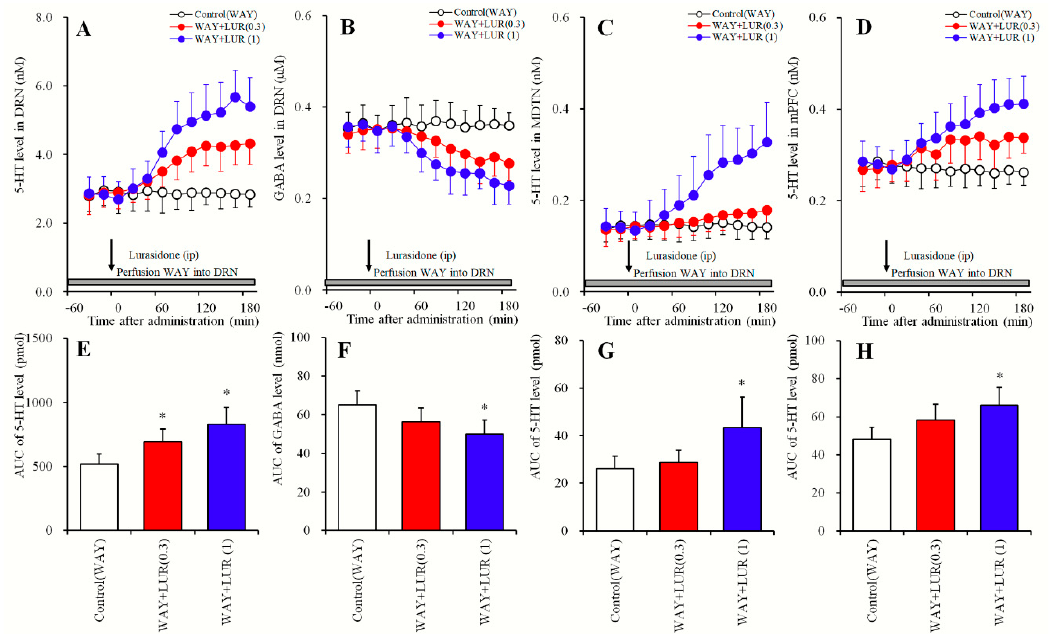
Figure 2. Dose-dependent e ff ects of systemic administration of lurasidone on extracellular levels of 5-HT in the DRN, MDTN, mPFC and GABA in the DRN during 5-HT1AR inhibition in the DRN (Study_2). ( A , C , D ) indicate dose-dependent e ff ects of systemic administration of lurasidone (LUR: 0, 0.3 and 1 mg / kg) during perfusion with 10 µ M N-[2-[4-(2-Methoxyphenyl)-1- piperazinyl]ethyl]-N-2-pyridinylcyclohexanecarboxamide (WAY100635: WAY) into the DRN on extracellular levels of 5-HT in the DRN, MDTN and mPFC, respectively. ( B ) indicates dose-dependent e ff ects of systemic administration of lurasidone (0, 0.3 and 1 mg / kg) during perfusion with 10 µ M WAY100635 into the DRN on extracellular GABA level in the DRN. Y -axis: Mean ± SD (n = 6) of extracellular levels of 5-HT (nM) and GABA ( µ M); X -axis: Time after administration of lurasidone (min). Arrows indicate intraperitoneal administration of lurasidone, and gray bars indicate the perfusion with 10 µ M WAY100635. Microdialysis was conducted to measure the releases of 5-HT and GABA. ( E – H ) indicate the AUC value of extracellular levels of 5-HT (pmol) and GABA (nmol) after systemic administration of lurasidone from 20 to 180 min of ( A – D ), respectively. Opened, red and blue columns represent the AUC values of 0, 0.3 and 1 mg / kg lurasidone administration, respectively. * P < 0.05; relative to control (lurasidone free) by MANOVA with Tukey’s post hoc test.